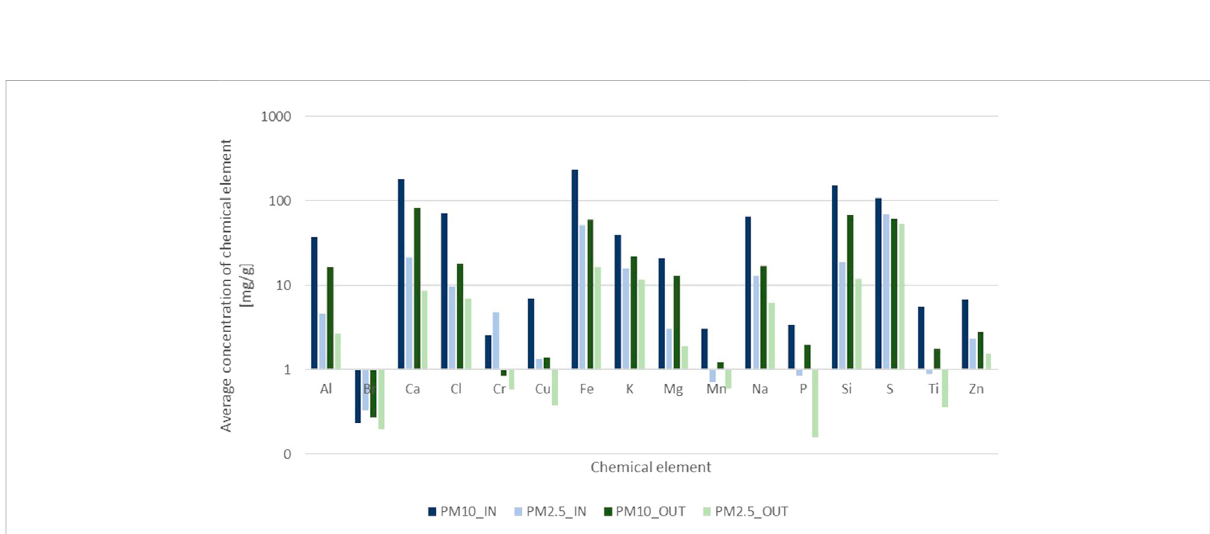
FIGURE 6 Average concentration ofchemicalelements inPM (milligrams of element per gram PM) during measurements in thePova ž ský Chlmec